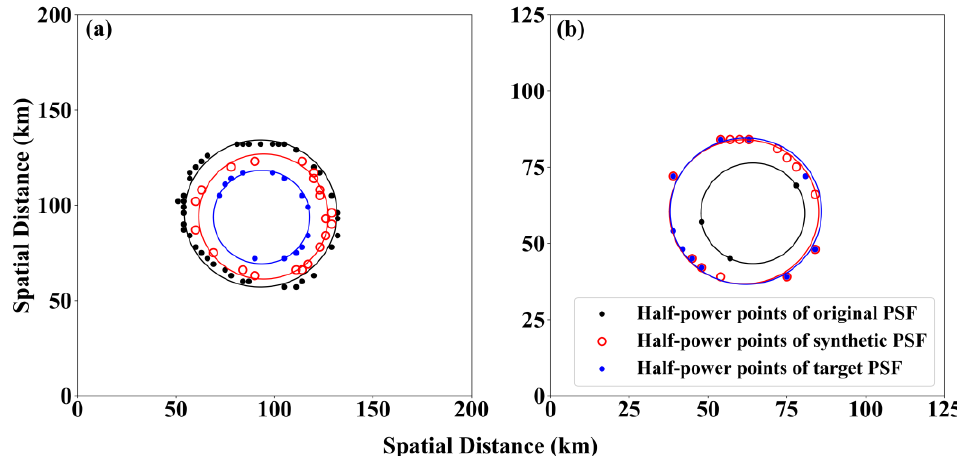
Figure 4. Half-power points and their circular curve fitting for ( a ) resolution enhancement and ( b ) degradation. The black, red, and blue markers and circular curves represent the half-power points and their fitting curves for the original, synthetic, and target PSFs, respectively.